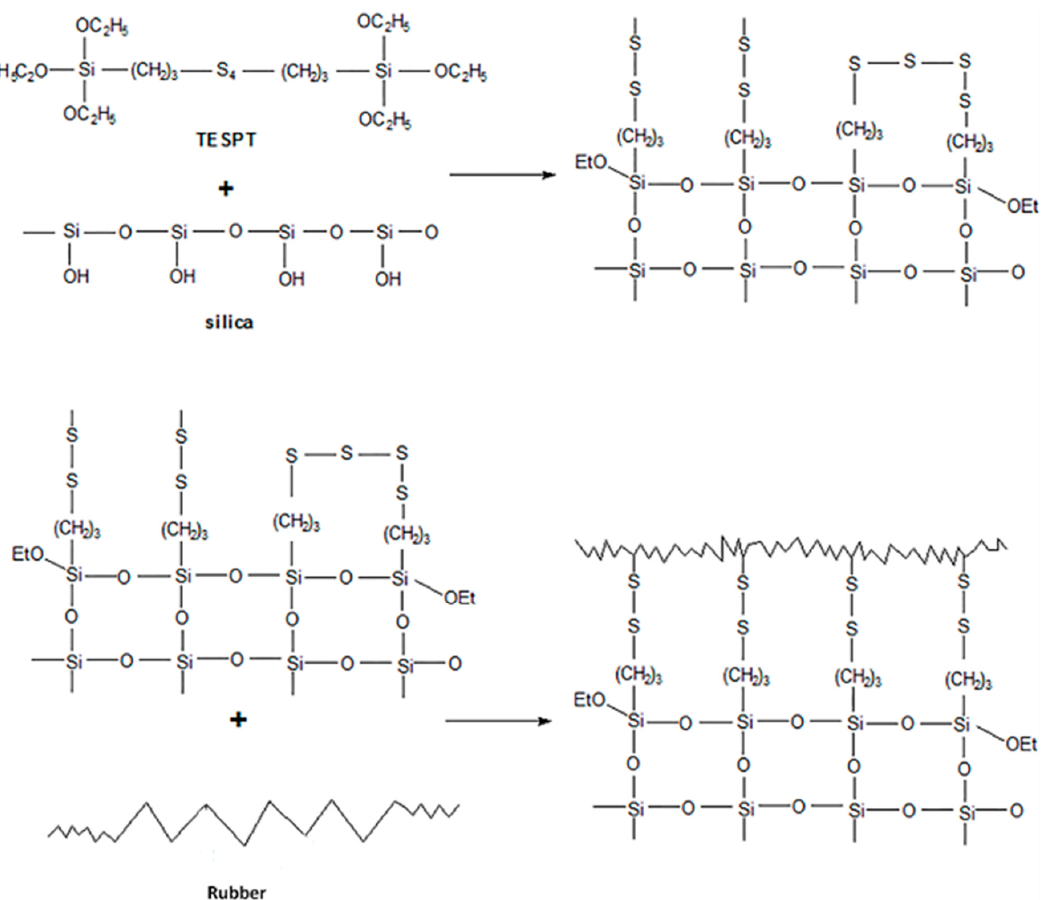
Figure 1. Silanization process between silica, a silane coupling agent (TESPE), and rubber.